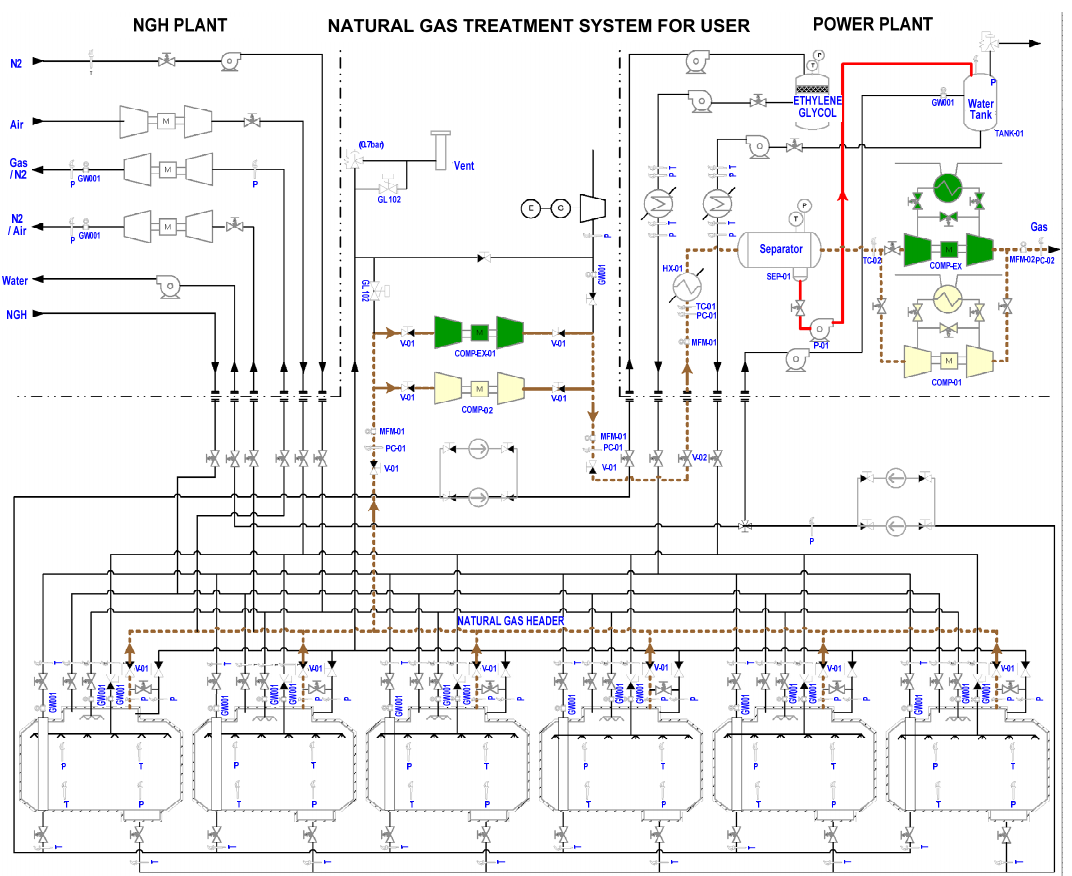
Figure 4. Conceptual flow diagram for NGH re-gasification